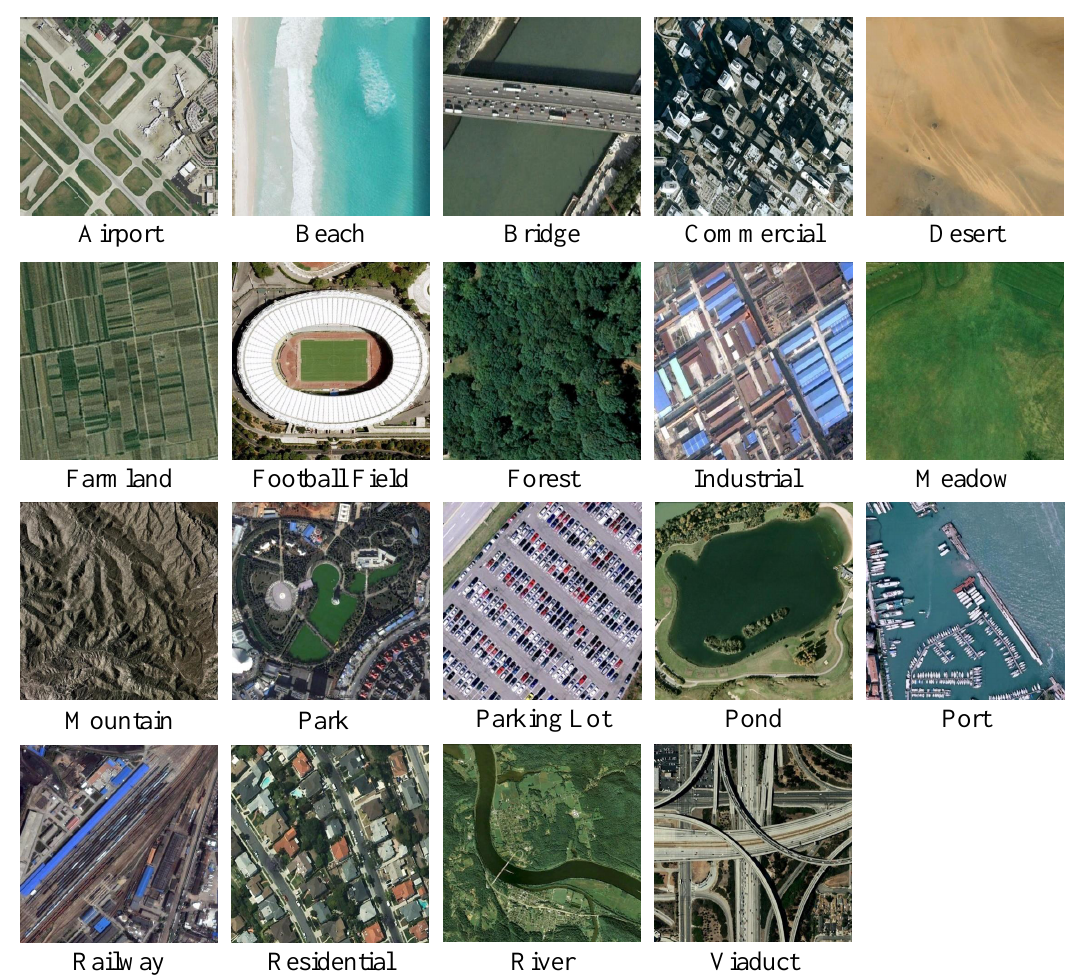
Figure 5. Examples of each category in the WHU-RS